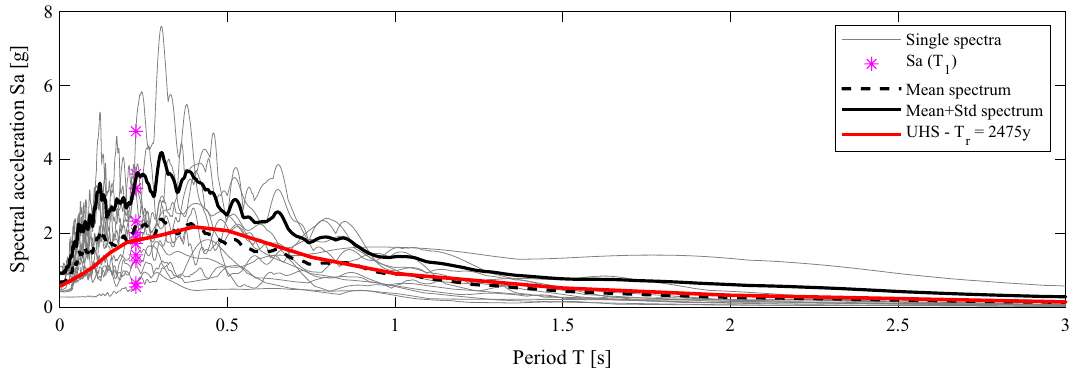
Figure 6. Response spectrum, mean spectrum and mean + standard deviation spectrum matching the UHS; in gray, each individual spectrum of Table